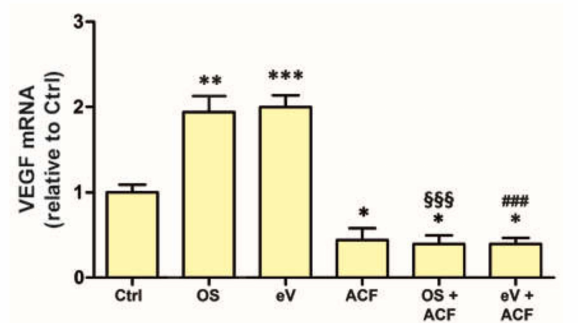
Figure 7. VEGF mRNA expression in MIO-M1 cells exposed to OS or to exo-VEGF (eV) for 24 h and e ff ect of the hypoxia inducible factor-1 inhibitor acriflavine (ACF) at 5 µ M. * p < 0.05, ** p < 0.01 and *** p < 0.001 relative to Ctrl; §§§ p < 0.001 relative to OS; ### p < 0.001 relative to eV. n =